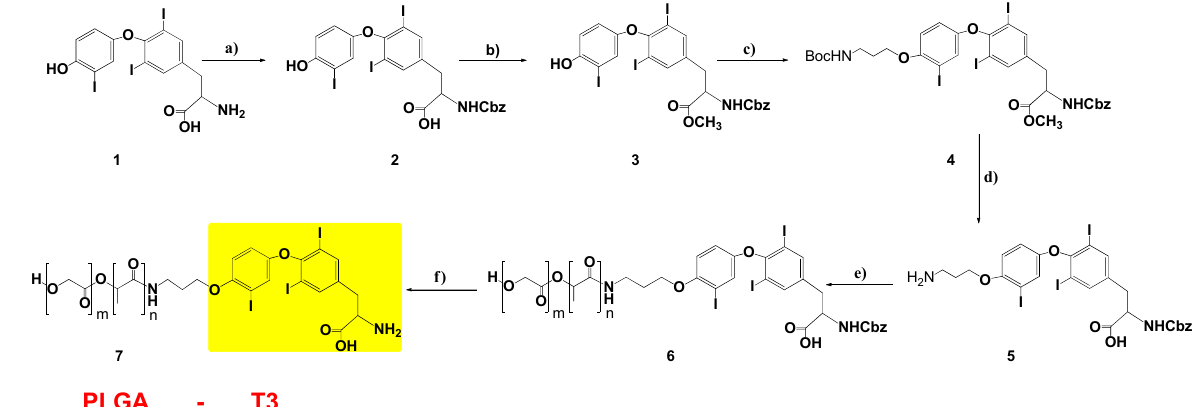
Figure 2. Synthesis of PLGA-T3. ( a ) Benzyl chloroformate, THF;water, rt, 4 h; ( b ) SOCl 2 , 0 °C–70 °C, 2 h; ( c ) tert-Butyl (3-bromopropyl) carbamate, ACN, K 2 CO 3 , reflux, 24 h; ( d ) HCl (4N in dioxane), rt, 24 h; ( e ) PLGA5k-NHS, DMSO, rt, 24 h; and ( f ) HBr (in 33% AcOH), DCM, rt, 24 h.